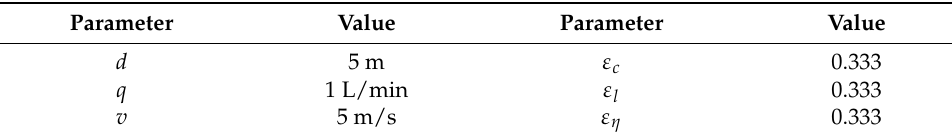
Table 1. Table of input